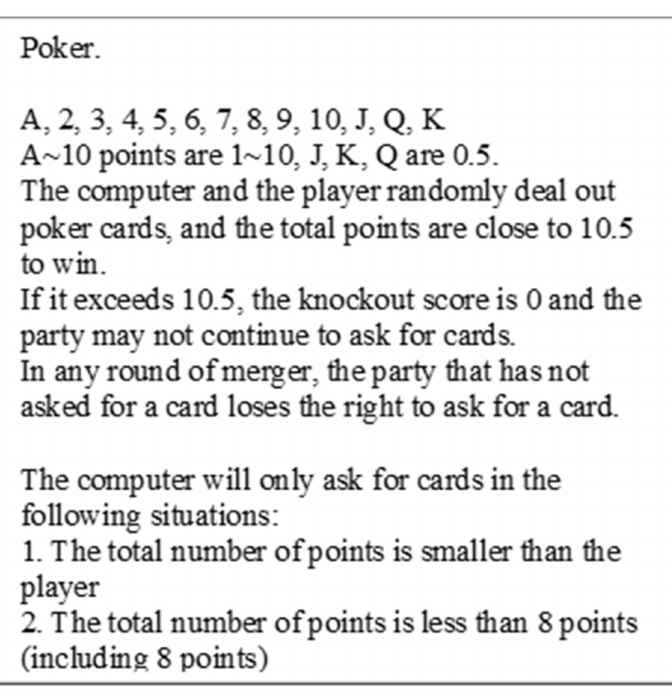
Figure 28. Test question (5).